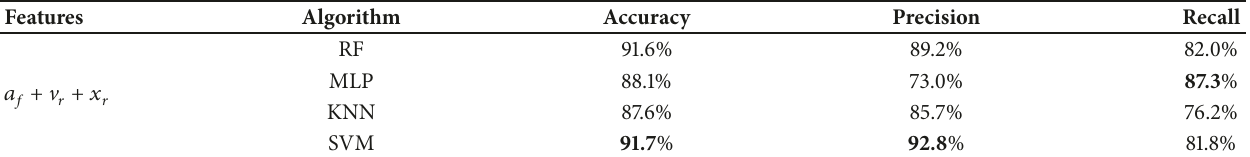
Table 8: The performance comparison of multiple